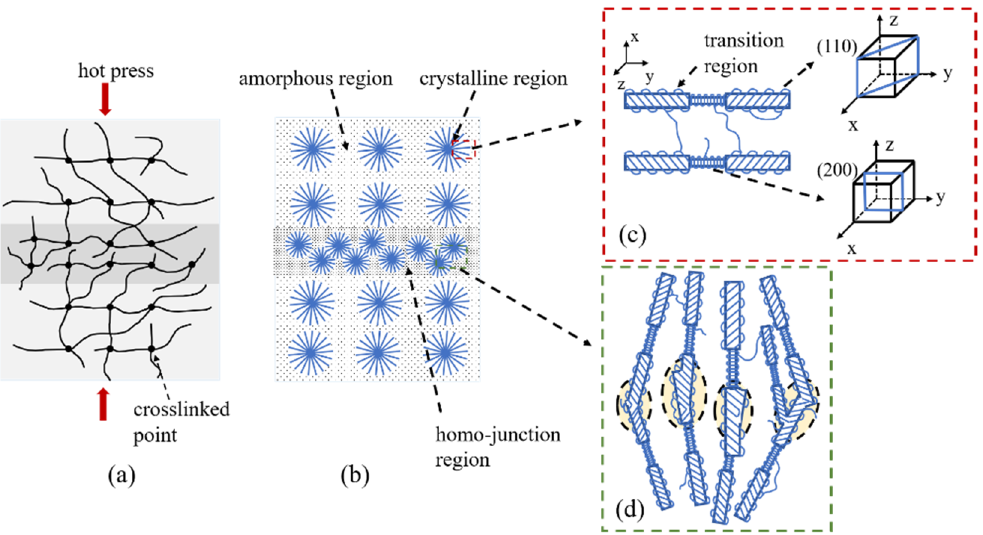
Figure 9. Schematic diagram of the H-XLPE bilayer: ( a ) crosslinked network during melting; ( b ) spherulites during cooling; ( c ) lattice plane orientation; ( d ) homo-junction region.